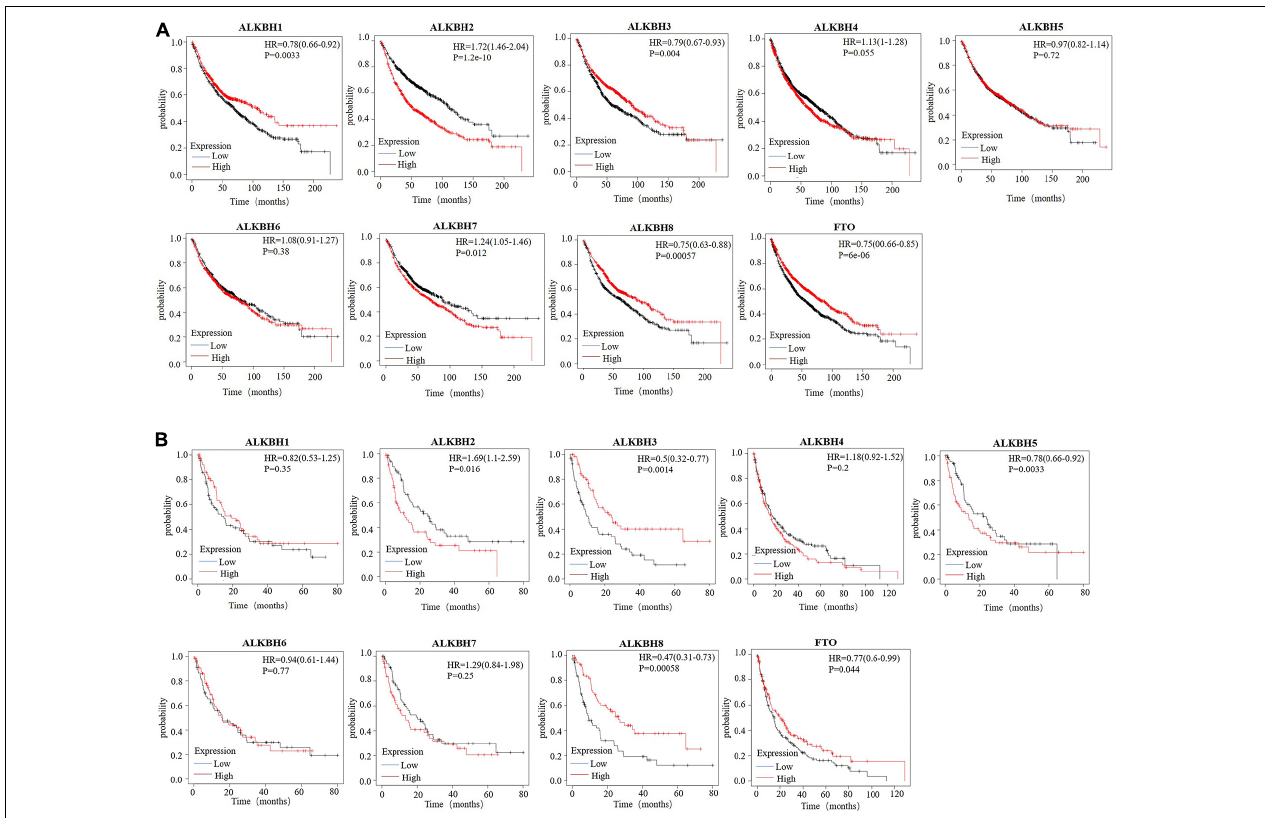
FIGURE 3 | (A) The overall survival curve of AlkB molecules in LUAD patients (Kaplan-Meier plotter). (B) The post-progressive survival curve of the AlkB molecules in LUAD patients (Kaplan-Meier